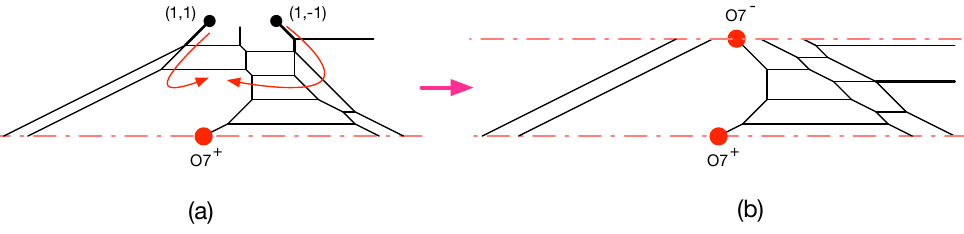
TAS + 1 Sym + 1 F theory. 2